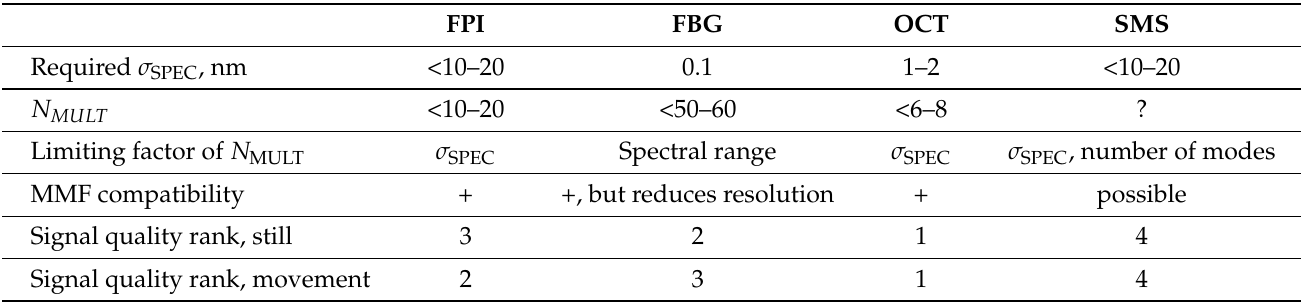
Table 3. Comparison of technical properties of the investigated sensors. σ SPEC —spectral resolution, N MULT —number of multiplexed